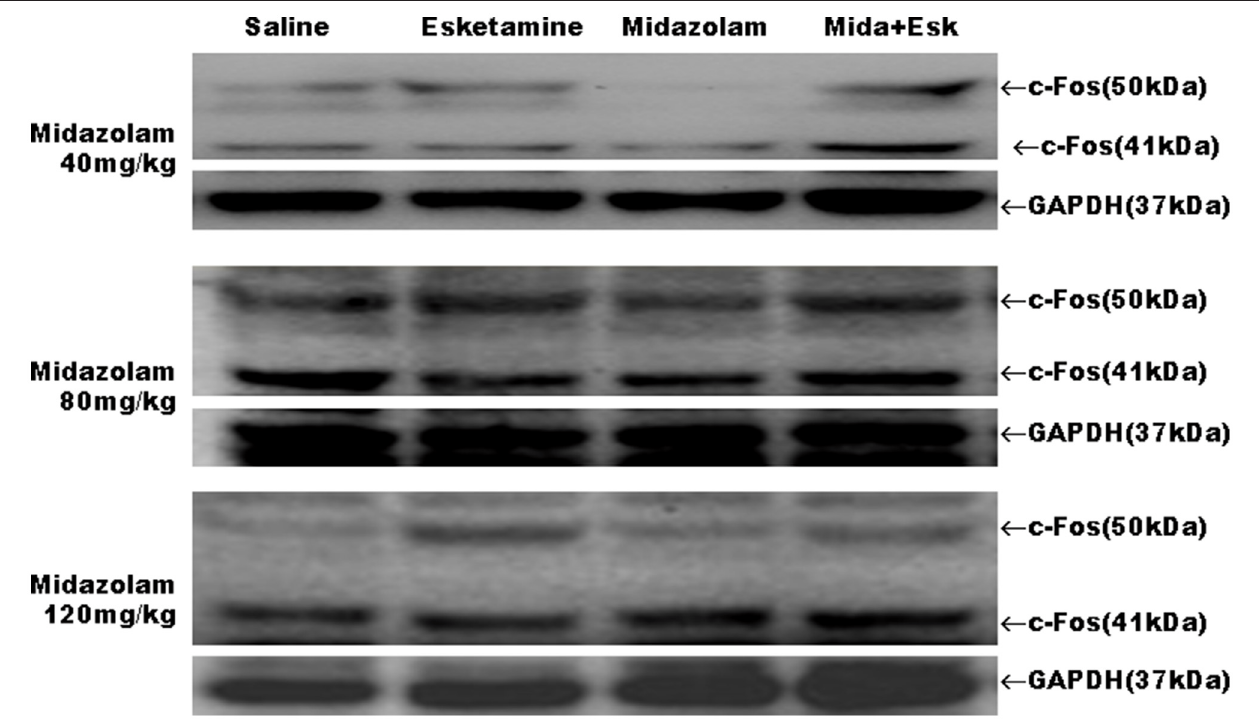
FIGURE 6 | Representative western blot results for c-Fos expression in mice